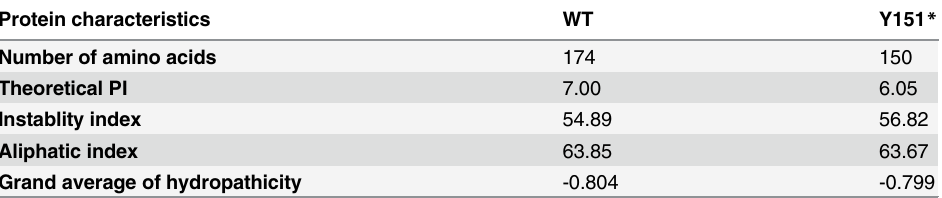
Table 1. Comparison of CRYGD wildtype and mutant. Protein characteristics WT Y151 * Number of amino acids 174 Theoretical